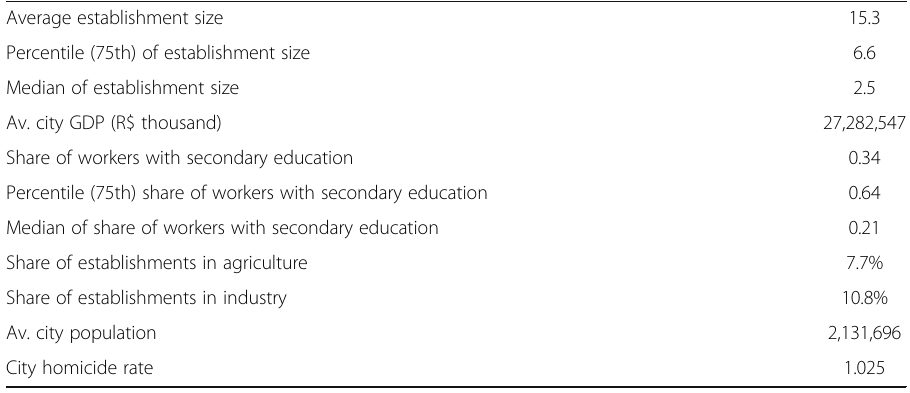
Table 7 Summary statistics for all city-level time-varying control variables